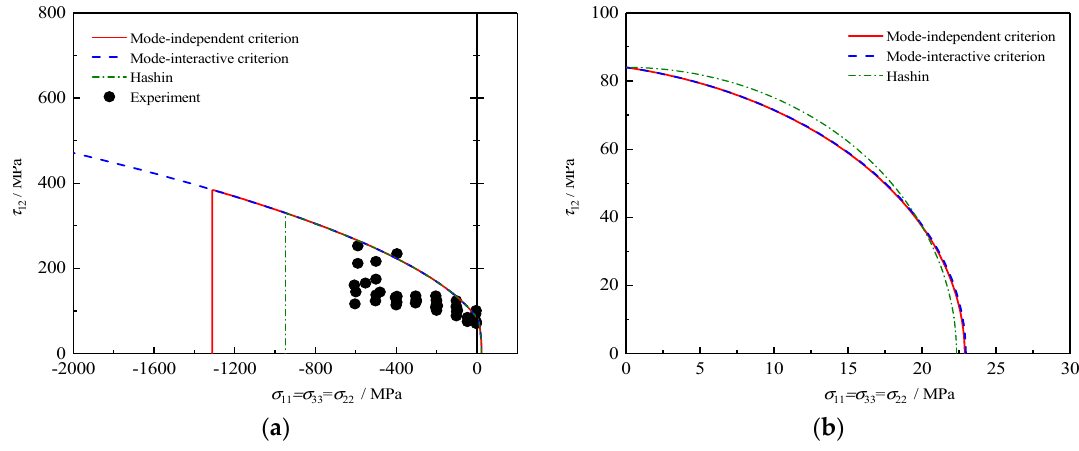
σ − σ = σ = σ 22 (where 22 33 ) for 12 11 - τ σ (where = = σ σ σ ) for 12 22 11 22 33